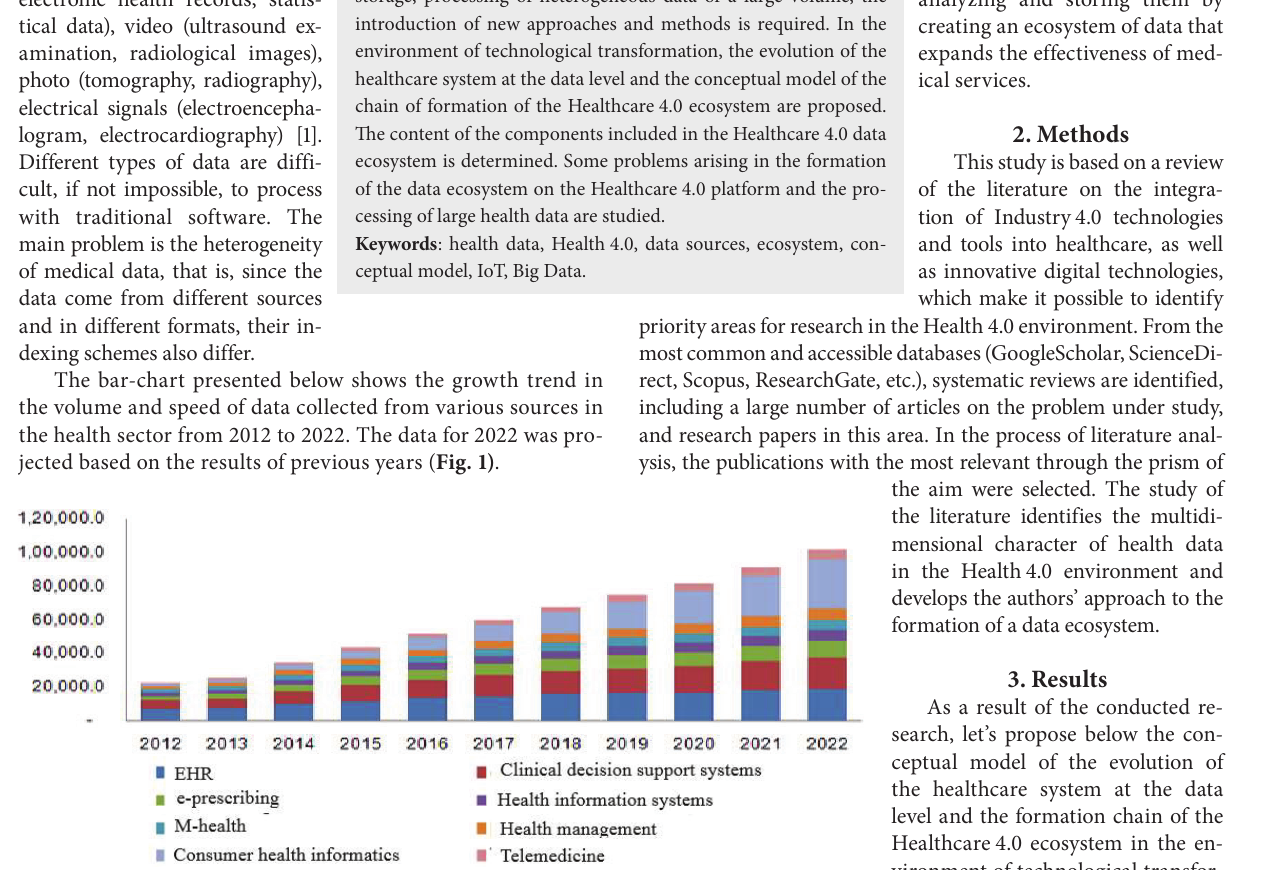
Fig. 1. Growth tendency of data volume and velocity in 2012−2022